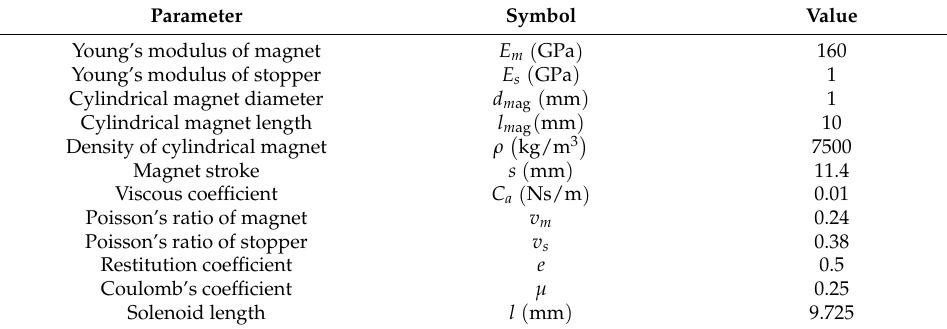
Table 1. Designed mechanical parameters of the